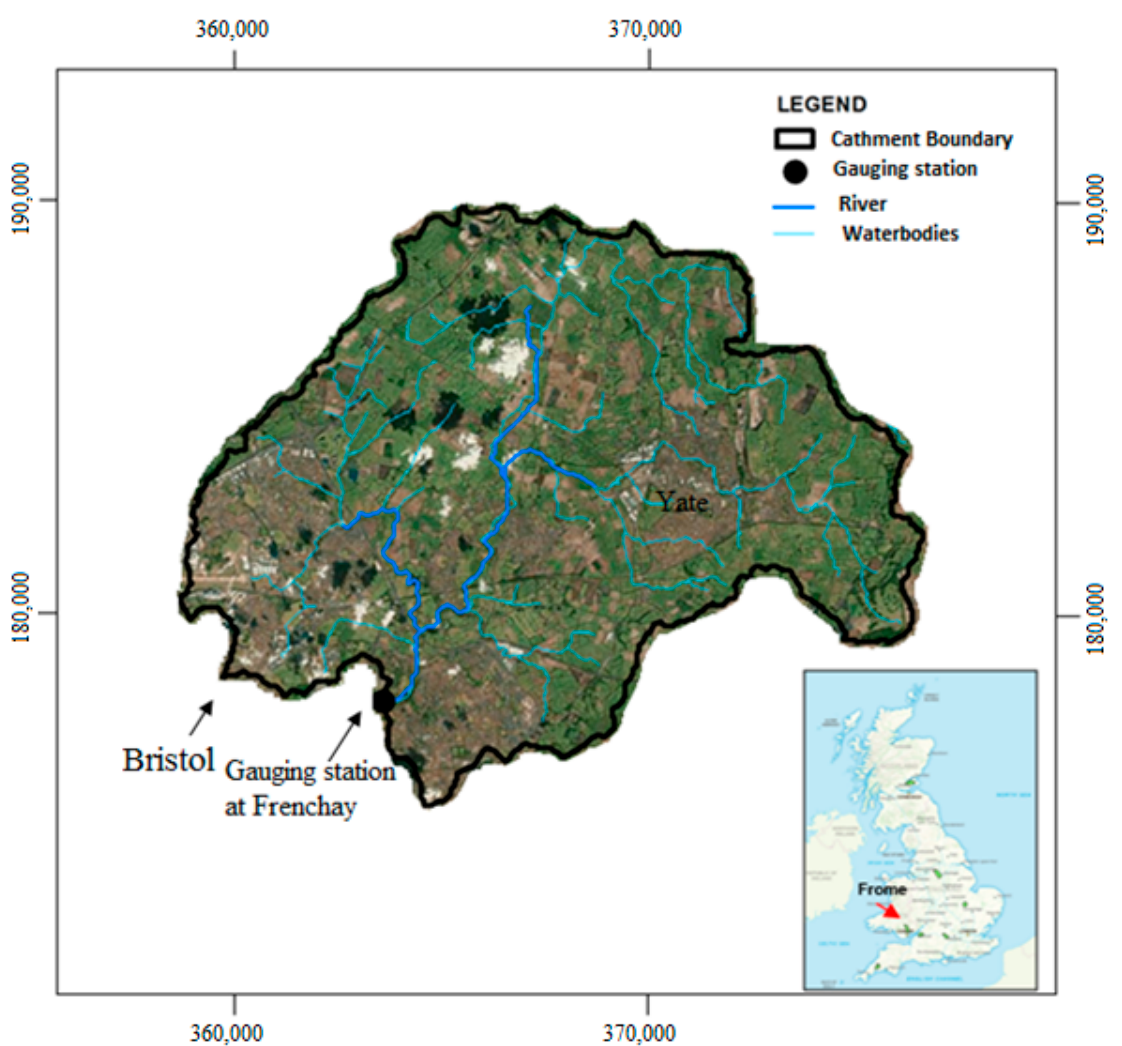
Figure 1. The River Frome, its catchment boundary and the location of the gauging station.